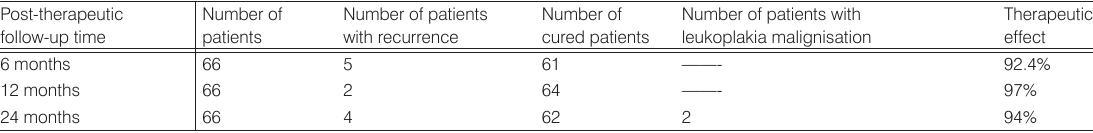
Table 6. Therapeutic effect of diode laser application in leukoplakias by patient number Post-therapeutic follow-up time